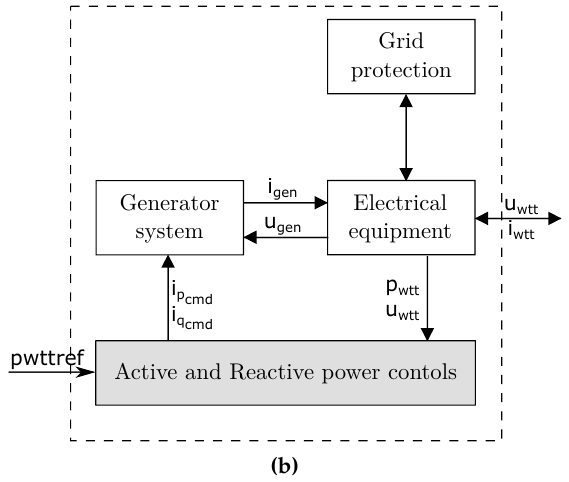
Figure 2. Configuration of a Type IVA wind turbine. ( a ) Main elements; and ( b ) corresponding model block